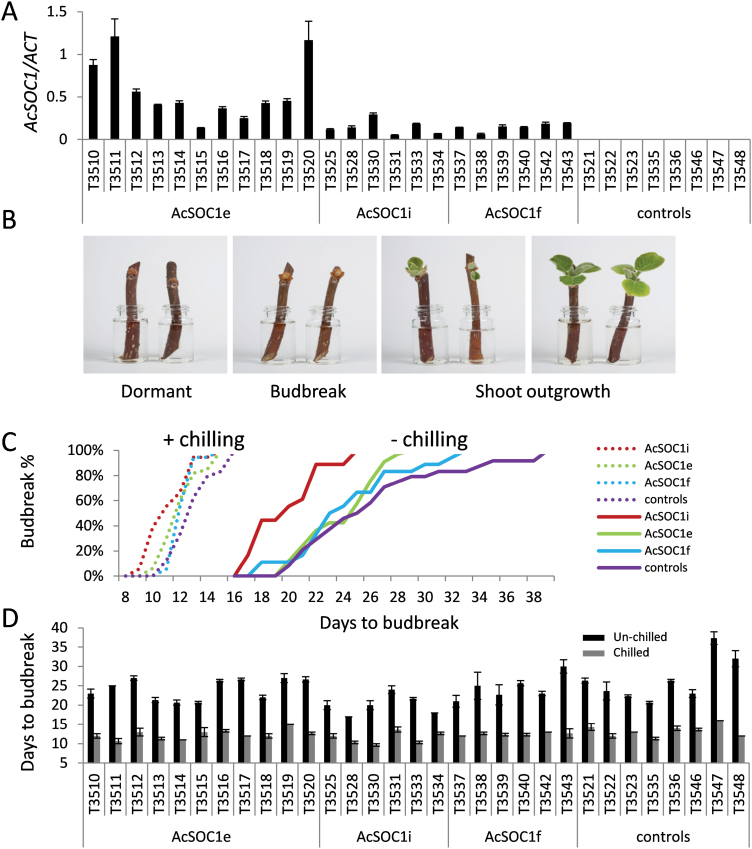
Constitutive expression of kiwifruit SOC1-like genes in transgenic kiwifruit Actinidia chinensis. (A) Relative expression of kiwifruit SOC1-like transgenes in A. chinensis transgenic lines. (B) Examples of A. chinensis single-node cuttings at the indicated stages. (C) Percentage of cuttings at the budbreak stage. (D) Average budbreak time of individual transgenic lines. Error bars represent SEs for three cuttings.